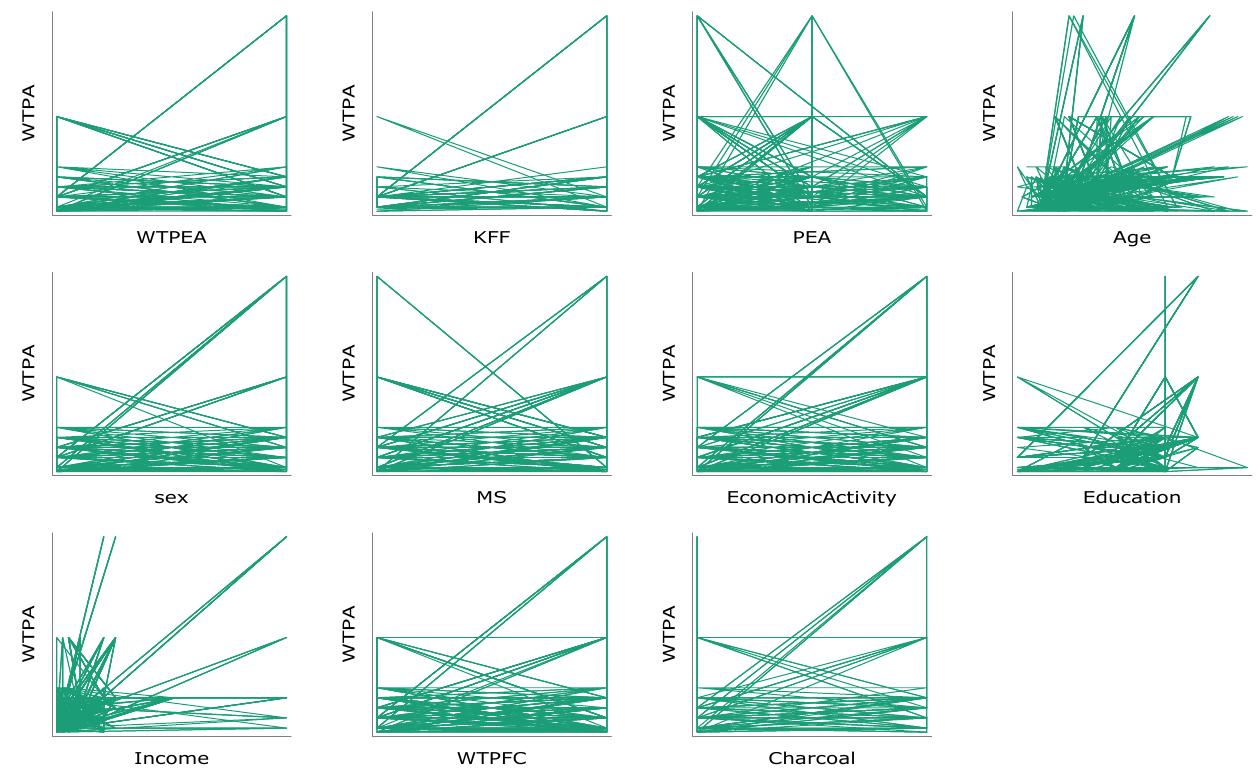
Figure 10. Plot of the WTPA against other variables. Table 5. Determinants of the willingness to pay amount (WTPA).